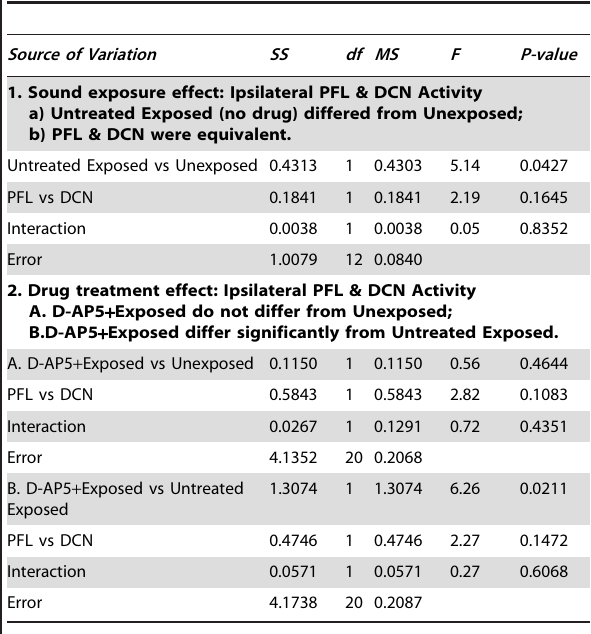
Table 2. Anova summary of MEMRI